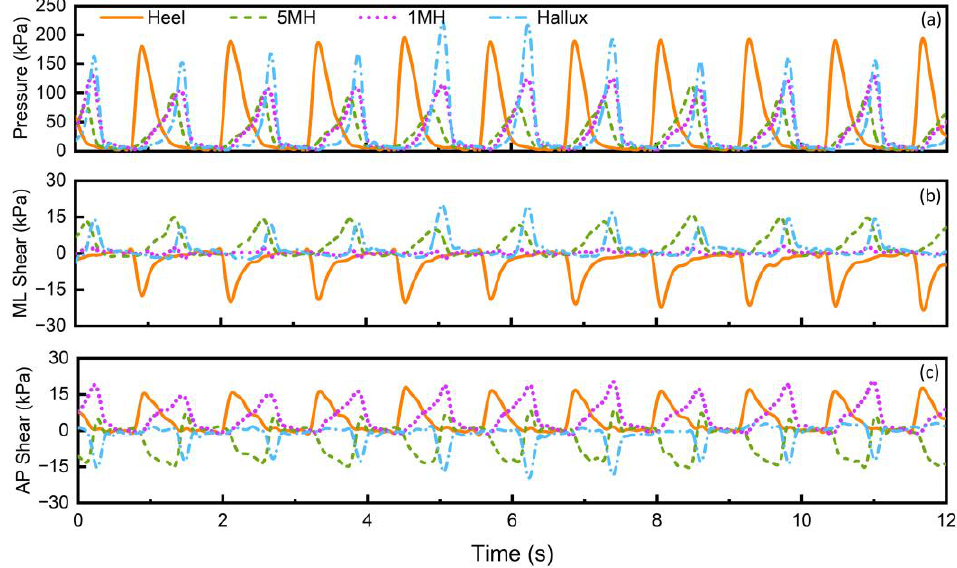
Figure 8. ( a ) Pressure, ( b ) medial – lateral (ML) shear and ( c ) anterior – posterior (AP) shear stress as a function of time from the healthy participant wearing a